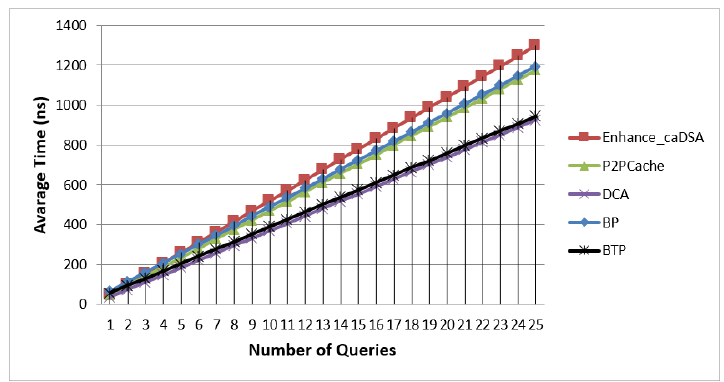
Figure 15. Average Time vs. Number of